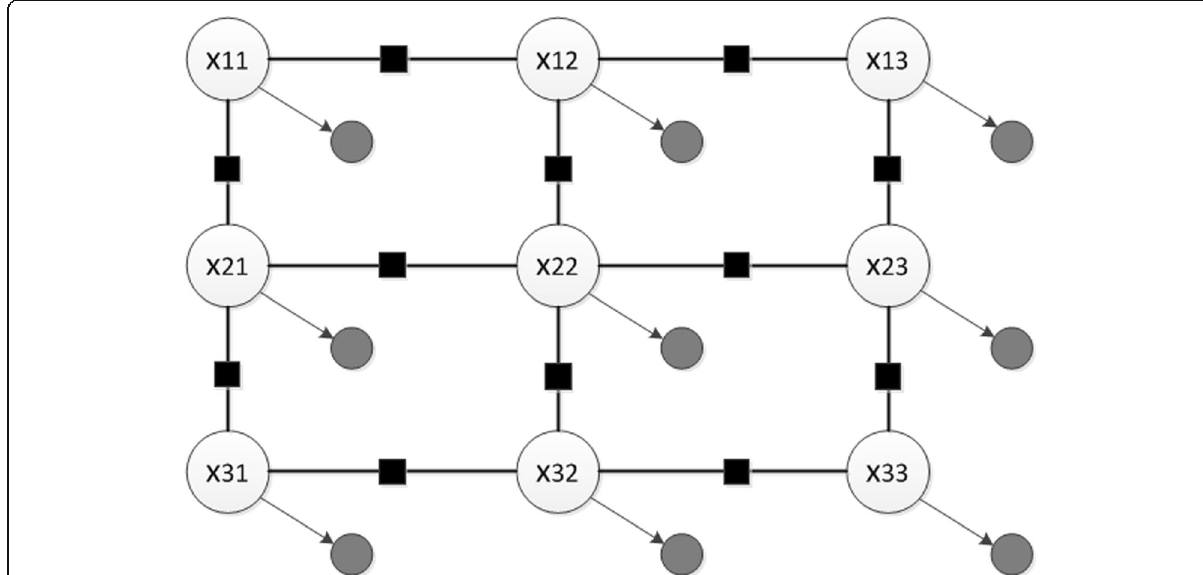
Fig. 1 Hidden Markov model of excursion set observation on discrete lattice in image